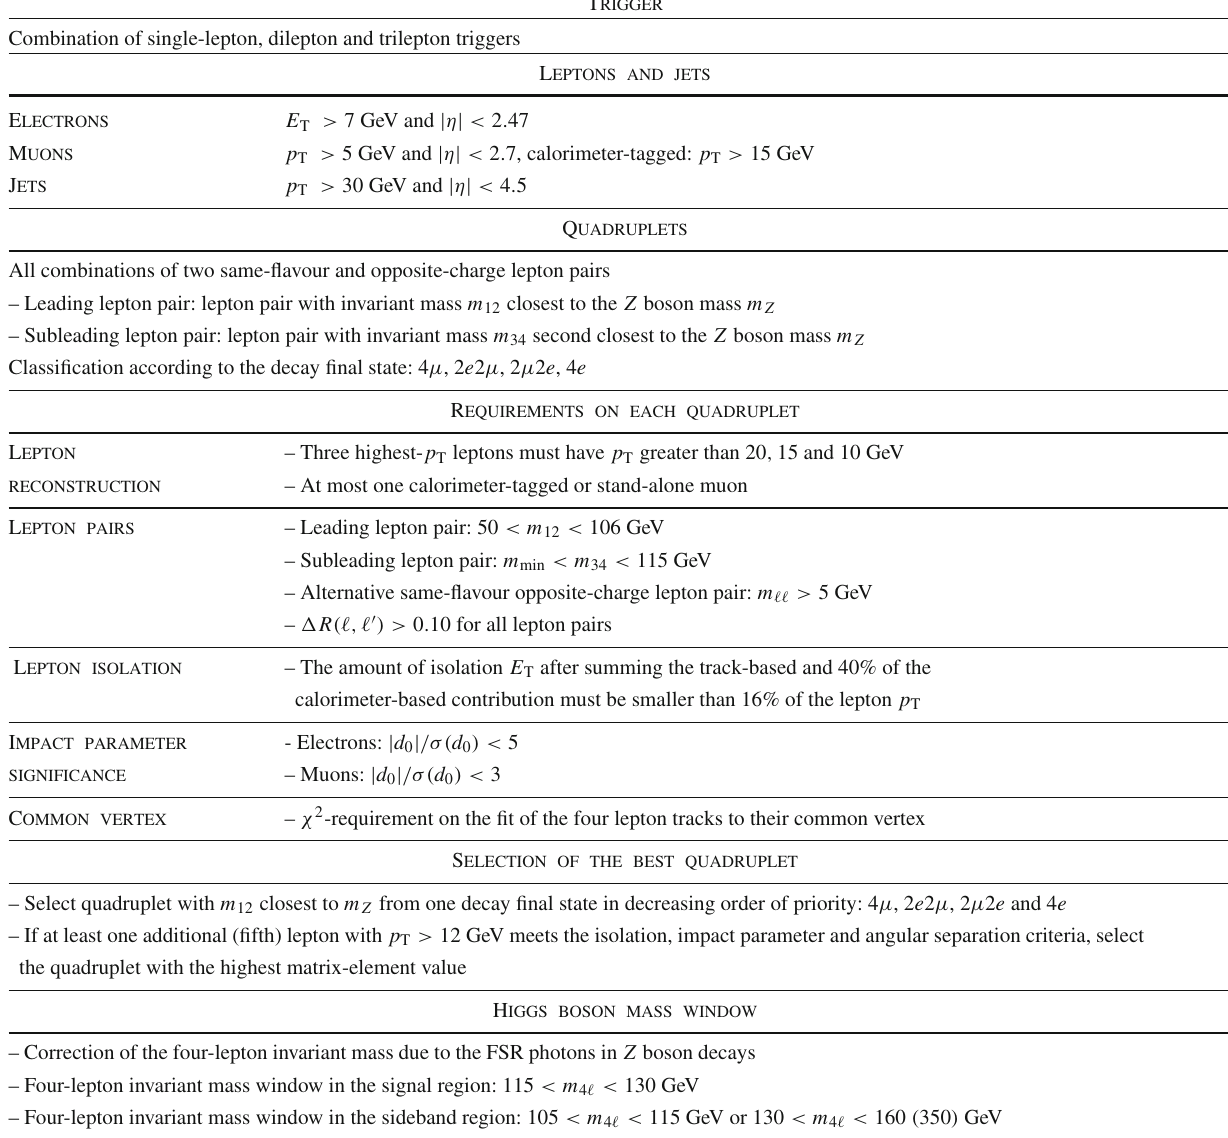
Trigger Leptons and